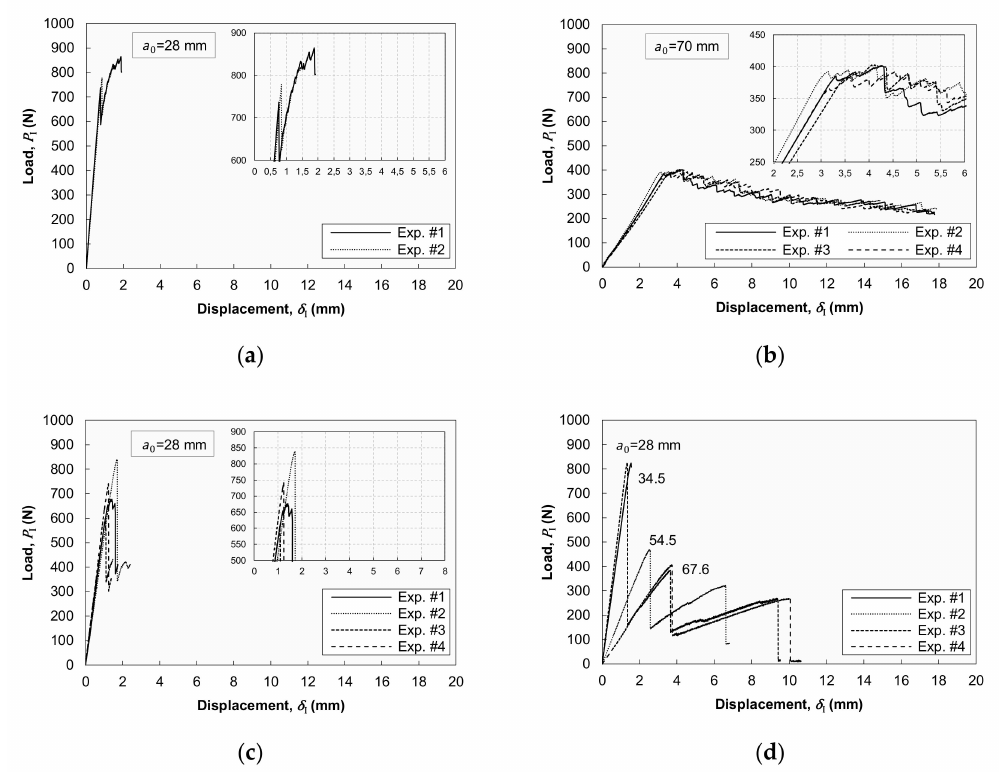
Figure 6. Load ( P I ) versus crack opening displacement ( δ I ) curves from the double cantilever beam (DCB) experiments for the four manufacturing options (MOs) under study: ( a ) MO 1, ( b ) MO 2, ( c ) MO 3, and ( d ) MO 4. a 0 is the initial crack